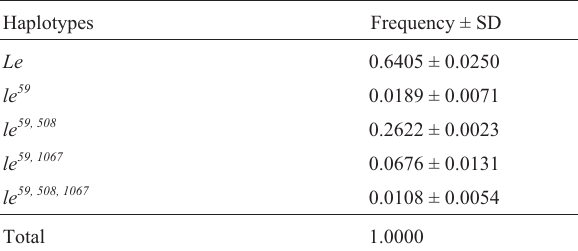
Table 2 - FUT3 gene haplotypic frequencies and their standard deviations (SD) identified using the Arlequin program.